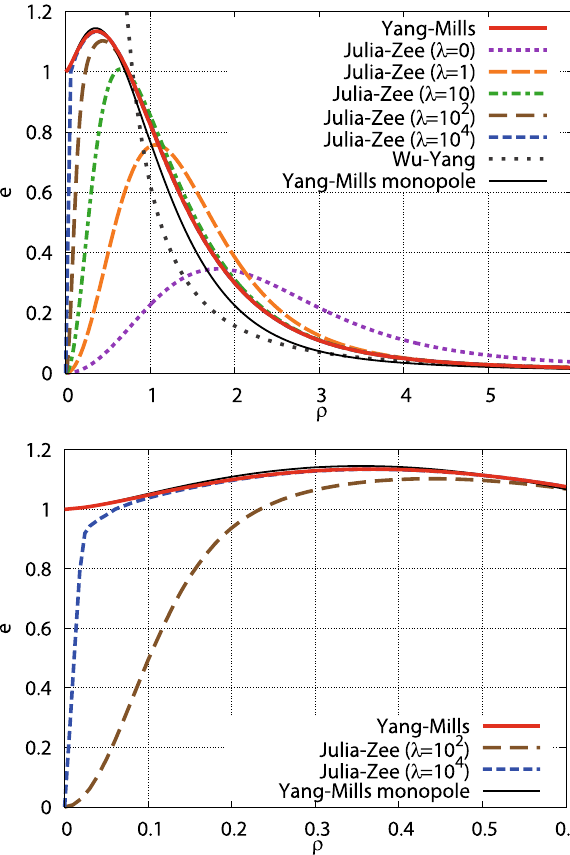
Fig. 5 The short-distance behaviors of (top panel) the gauge-invariant chromomagnetic field B r and (bottom panel) the gauge-invariant chro- moelectric field E r as functions of ρ = g v r at C = 0 . 5. The chromo- magnetic field of the Yang–Mills dyon diverges at the origin logarith- mically, just like the Yang–Mills monopole